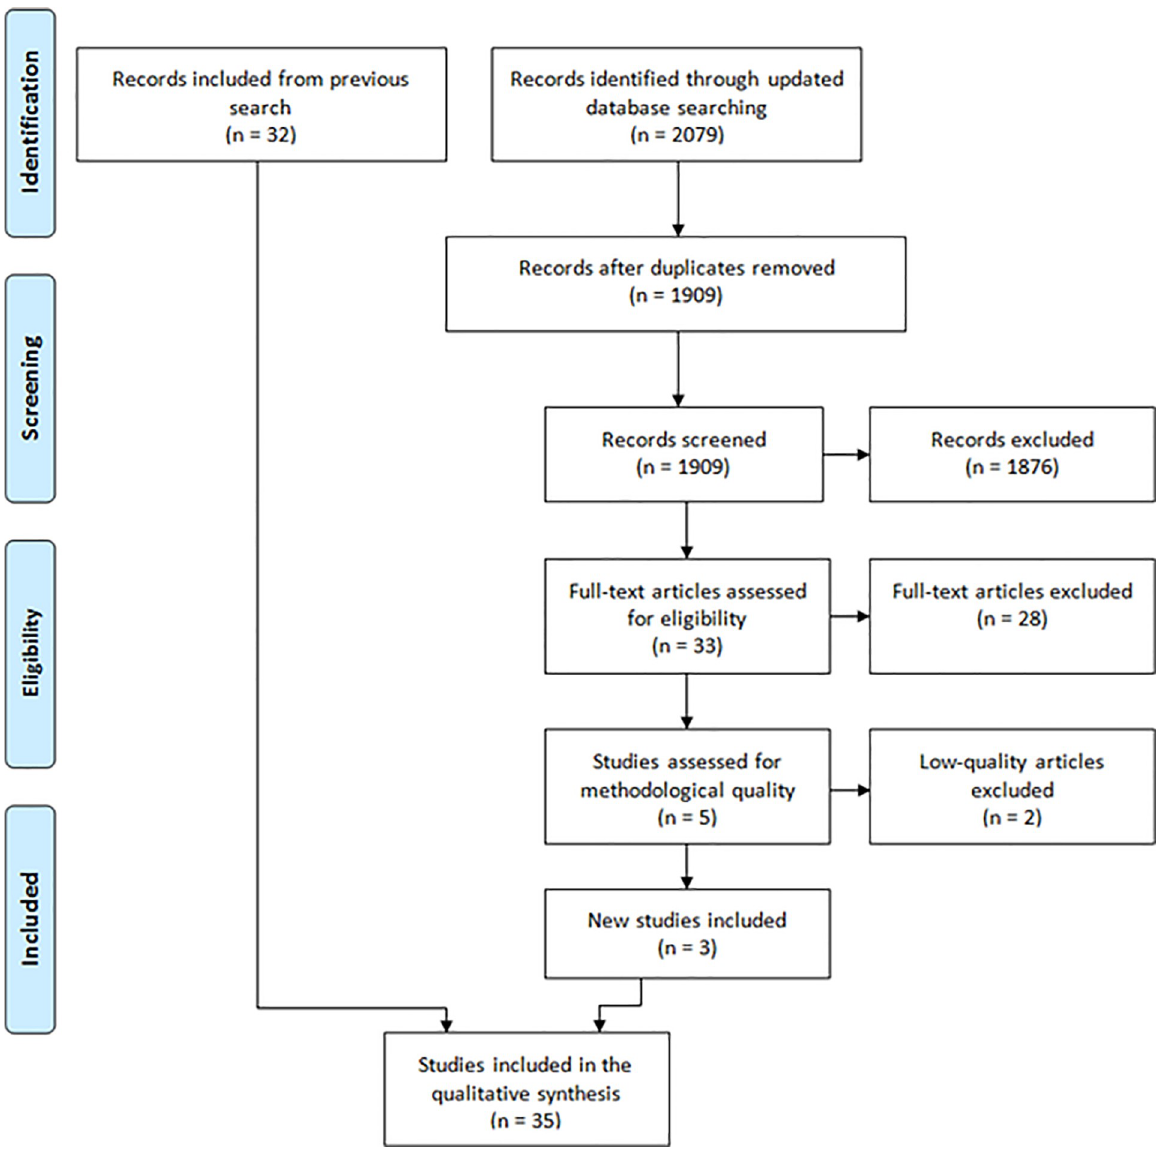
Fig 2. PRISMA flow diagram for updated search up to 4 th September